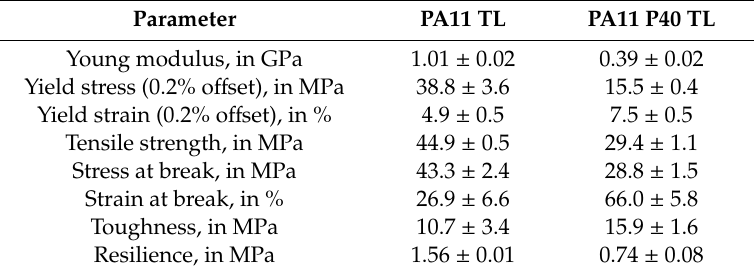
Table 2. Tensile parameters.